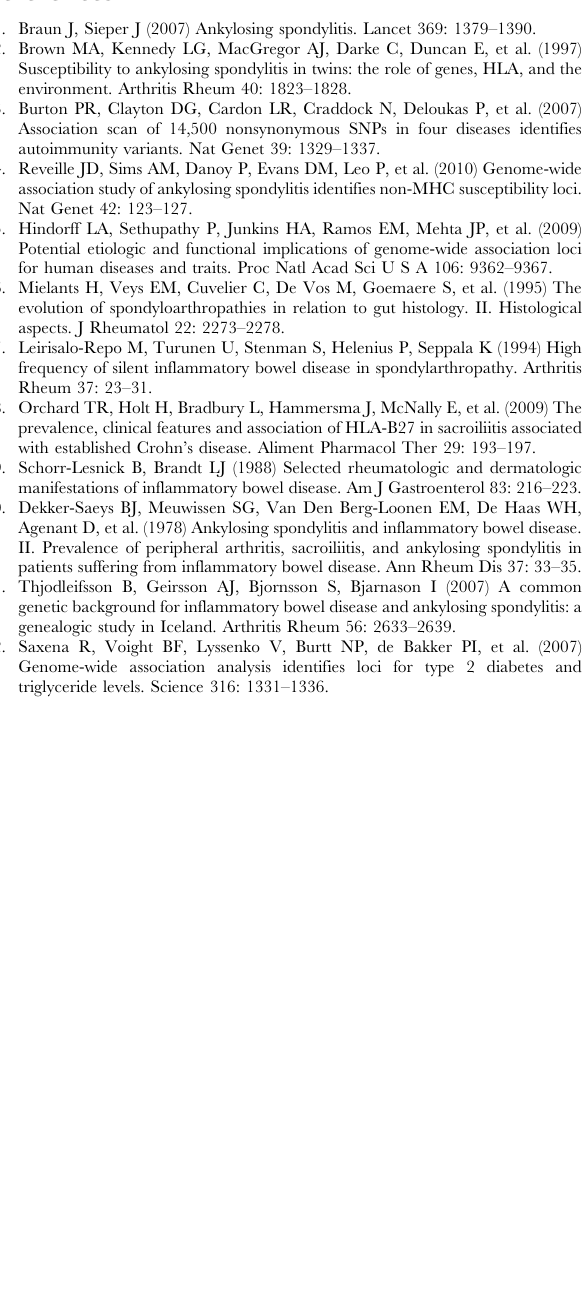
Table S1 Association study findings for phase 1 for all markers genotyped. Markers with blank case and control MAF